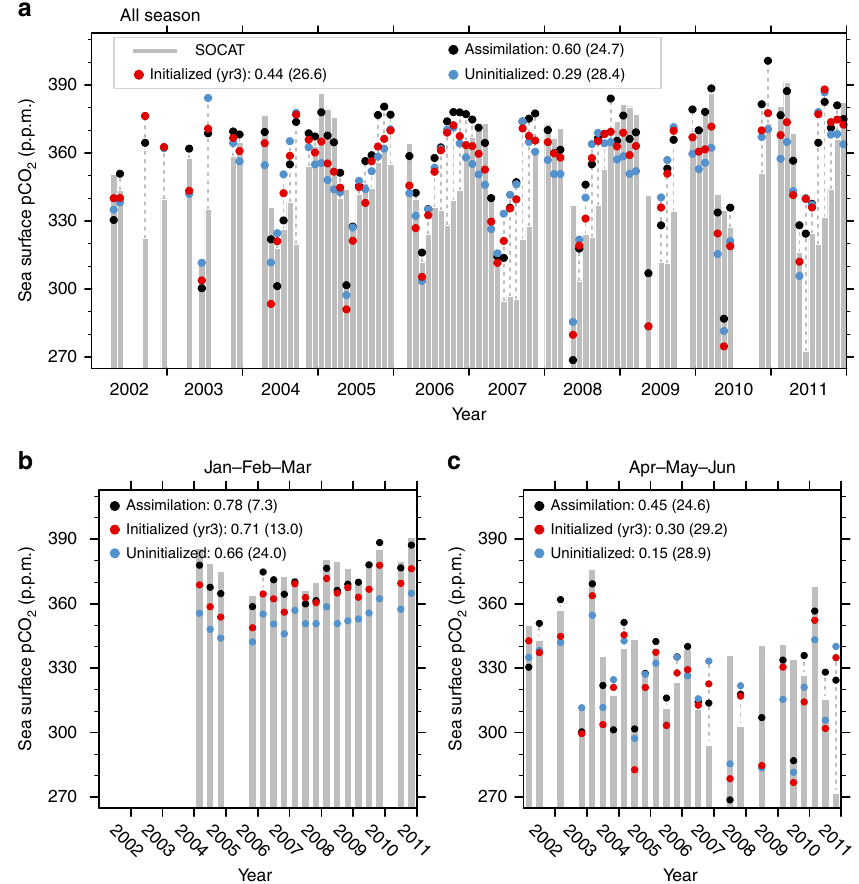
Figure 4 | Observed and model simulated monthly mean ocean surface pCO 2 in western SPG region. ( a ) All season time series, ( b ) only January–February–March are shown and ( c ) only April–May–June are shown. The SOCAT observations 36 are shown with grey bars, and model output of assimilation, uninitialized simulations and initialized simulations at a lead time of 3 years (yr3) are shown in black, blue and red dots, respectively. The grey dashed lines connect outlier dots with the grey bars to make the comparison clearer. The numbers in legend are correlation coefficients and root mean squared error (in brackets) between model simulations and SOCAT observations. For the all season time series in a the correlations of the assimilation and initialized simulations at lead time of 3 years are significantly larger than that of the uninitialized simulations at 95% significant level based on a bootstrap test. Note the SOCATobservational data are not continuously distributed in space and time; the model simulations are averaged over the grid points where SOCAT data are available.